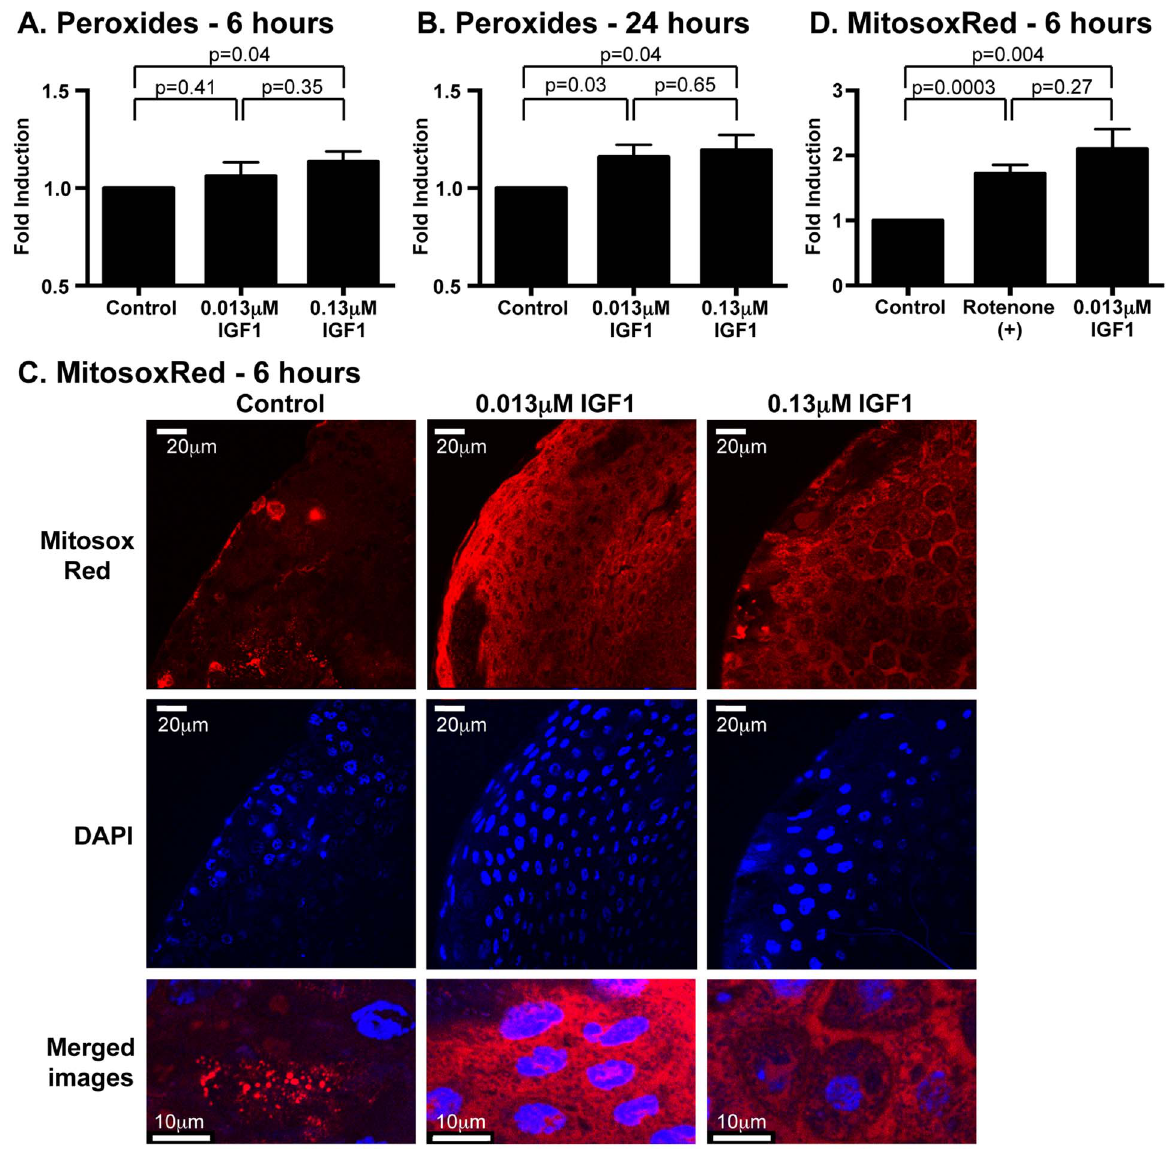
Figure 3. Ingested human IGF1 increased ROS levels in A.stephensi midguts. Peroxide levels were quantified at 6 h (A) and 24 h (B) following IGF1 treatment. Each data point represents the quantified peroxides in a pool of five midguts; three pools were collected per treatment per experiment. Data are represented as fold-change relative to saline/ATP-fed controls and were analyzed by unpaired t-test. Experiments were replicated three times with separate cohorts of mosquitoes and p-values are indicated. (C) Representative images from confocal microscopy of MitoSOX Red stained midguts. Upper Panel: MitoSOX Red staining, scale bars=20 m m; Middle Panel: DAPI staining scale bars=20 m m; Lower Panel: Merged images, scale bars=10 m m. Differences in nuclei size are due to differences in focal plane not magnification. (D) Mitochondrial superoxide levels were quantified from MitoSOX Red fluorescence. Average fold inductions 6 SEM of MitoSOX Red fluorescence from low IGF1 (0.013 m M) and a positive control (1 m M rotenone) relative to controls. Data were analyzed by unpaired t-test